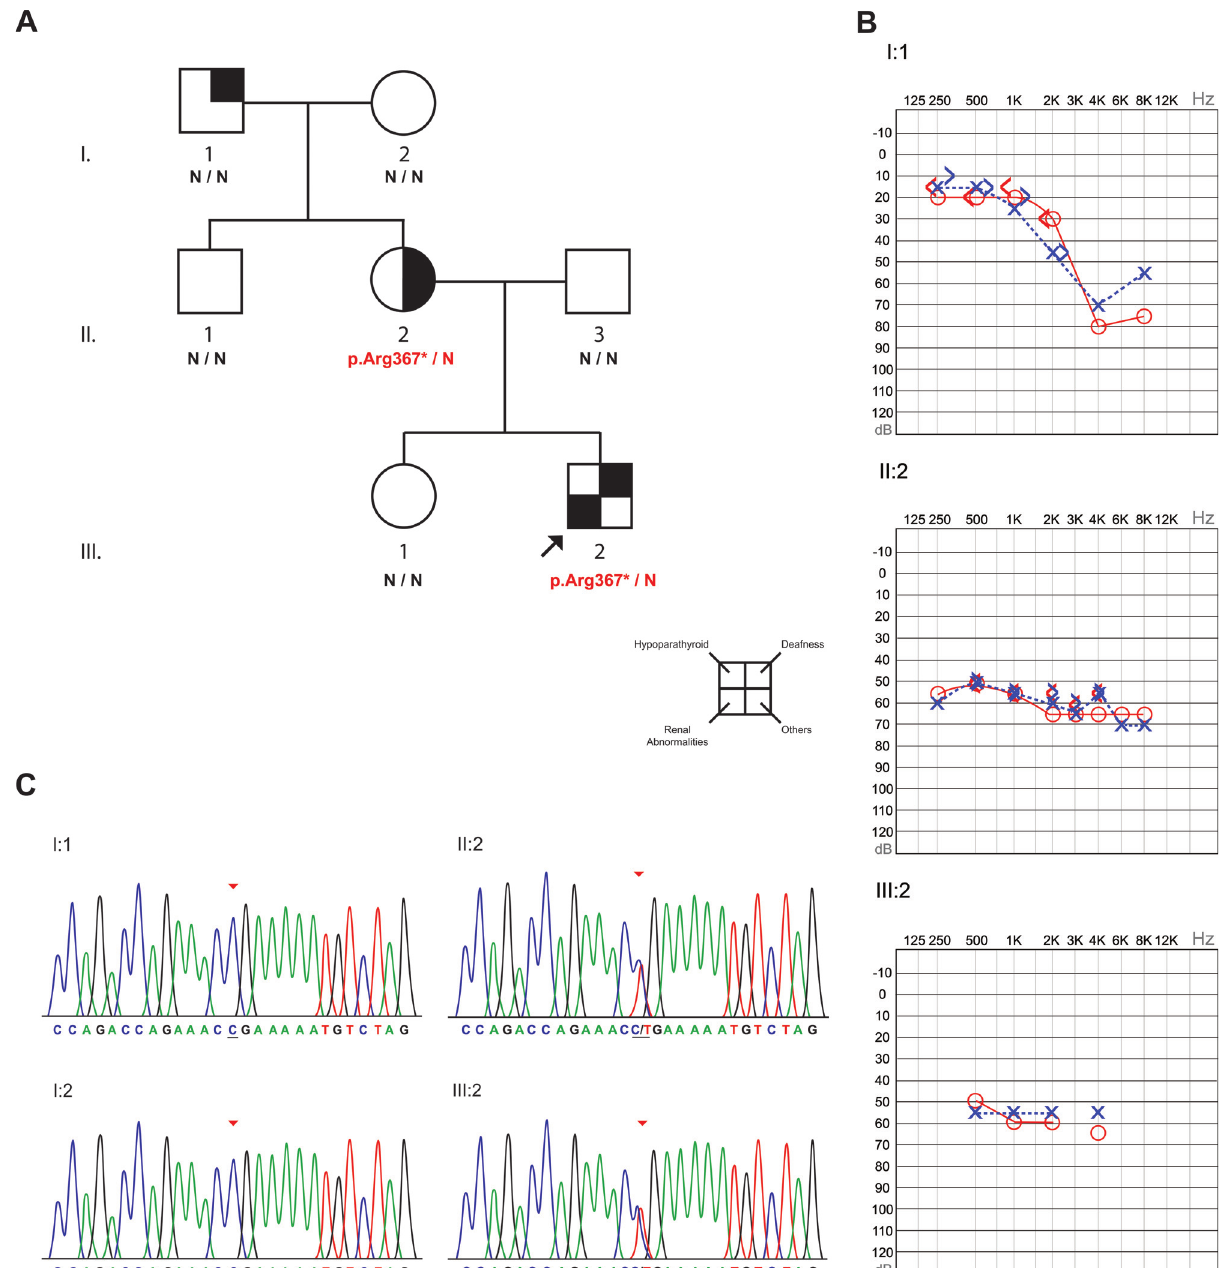
Figure 1 - Results of the analyzed family. A) Pedigree of the studied family with the genetic screening for the p.Arg367* mutation in the GATA3 gene. For the individual II:2, the square denoting other clinical manifestations is marked due to her bicuspid aortic valve. B) Audiograms of the three affected members of the family. Individual I:1 (74 years old) presented normal hearing in low frequencies and a bilateral slope at 4KHz, with an improvement in hearingat8KHz.TheII:2(37yearsold)andIII:2(4yearsold)presentedbilateralsensorineuralmoderatetoseverehearingloss.C)Electropherogramsof the proband (III:2), his mother (II:2) and his grandparents (I:1 and I:2), which indicate a case of de novo mutation in the mother of the